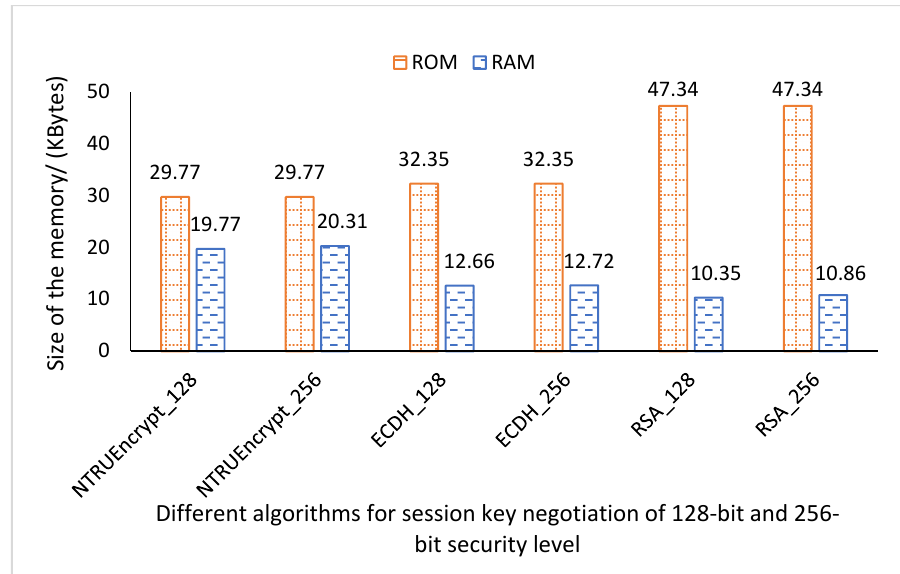
Figure 7. Comparison of memory occupation of different algorithms.